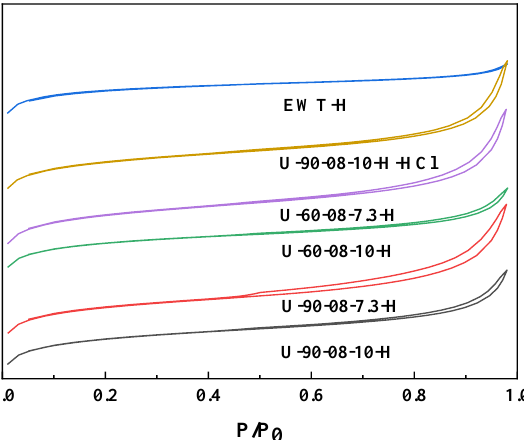
Figure 7. The isotherm plots of samples.